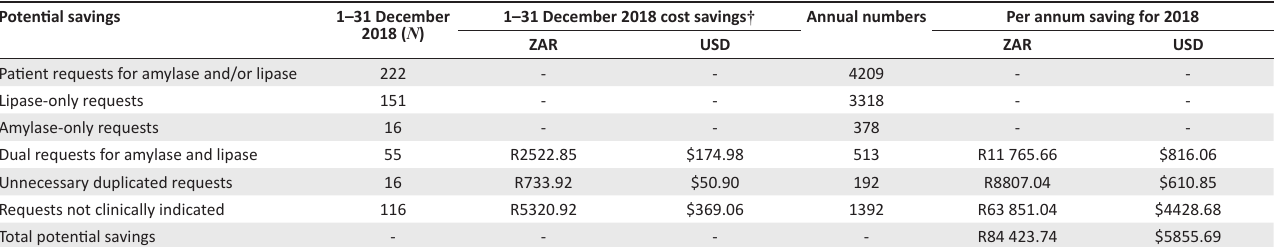
TABLE 3: Amylase and lipase test requests and predictive cost savings, Tygerberg Hospital, 1–31 December 2018. Potential